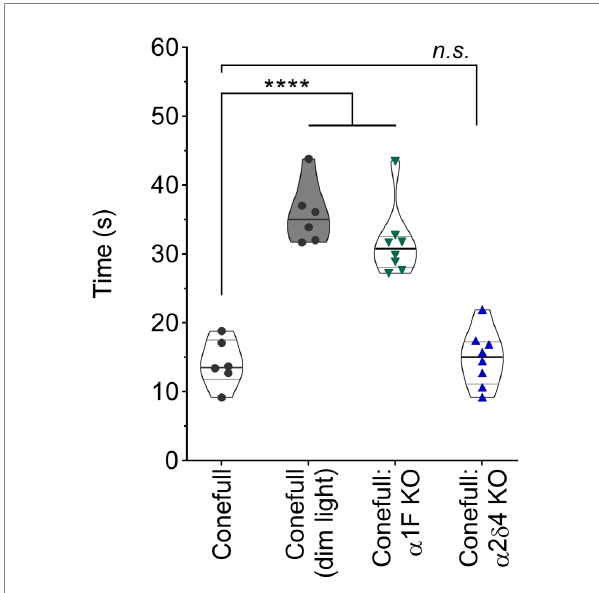
FIGURE 2 Vision dependent navigation is defective in Conefull: α 1F KO. Time to reach the visible escape platform for Conefull animals under photopic (black circles) or scotopic (black circles, shaded violin plot) lighting compared to Conefull: α 1F KO (green triangles) or Conefull: α 2 δ 4 KO (blue triangles) under photopic lighting.